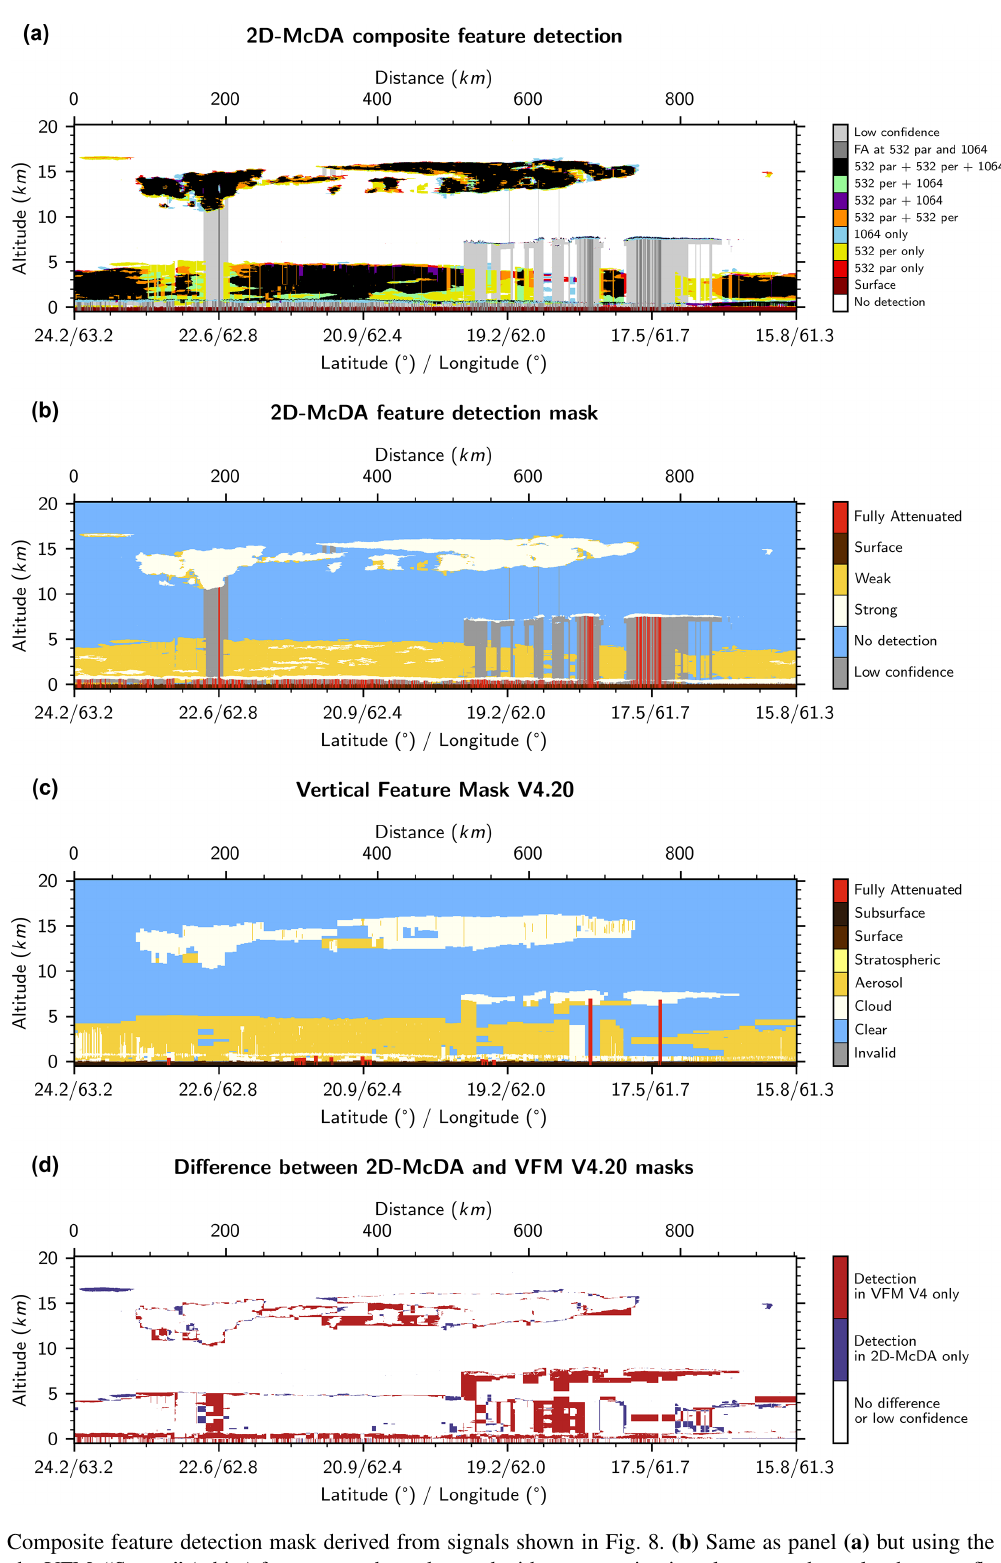
Figure 9. (a) Composite feature detection mask derived from signals shown in Fig. 8. (b) Same as panel (a) but using the same colors as those used for the VFM. “Strong” (white) features are those detected without averaging in at least one channel; others are flagged as “weak” (yellow). (c) VFM of version 4 of the CALIOP data product. (d) Difference between the new mask and the